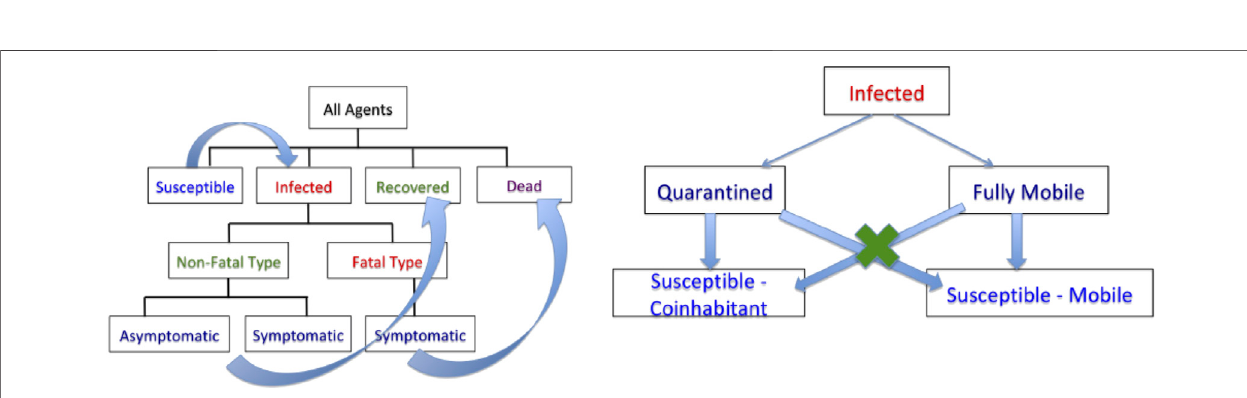
FIGURE 2 | Left: fl ow chart for evolution of infection dynamics for the population. Right: scheme for infection of susceptible agents from infected